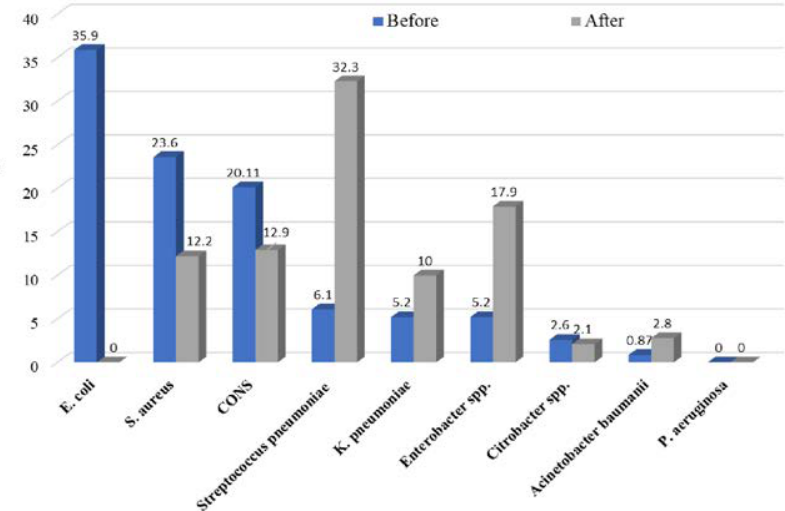
Fig. 1. Distribution of microorganisms isolated from blood samples before and after the implementation of culture- based antibiotic policy and restricted infection control guidelines